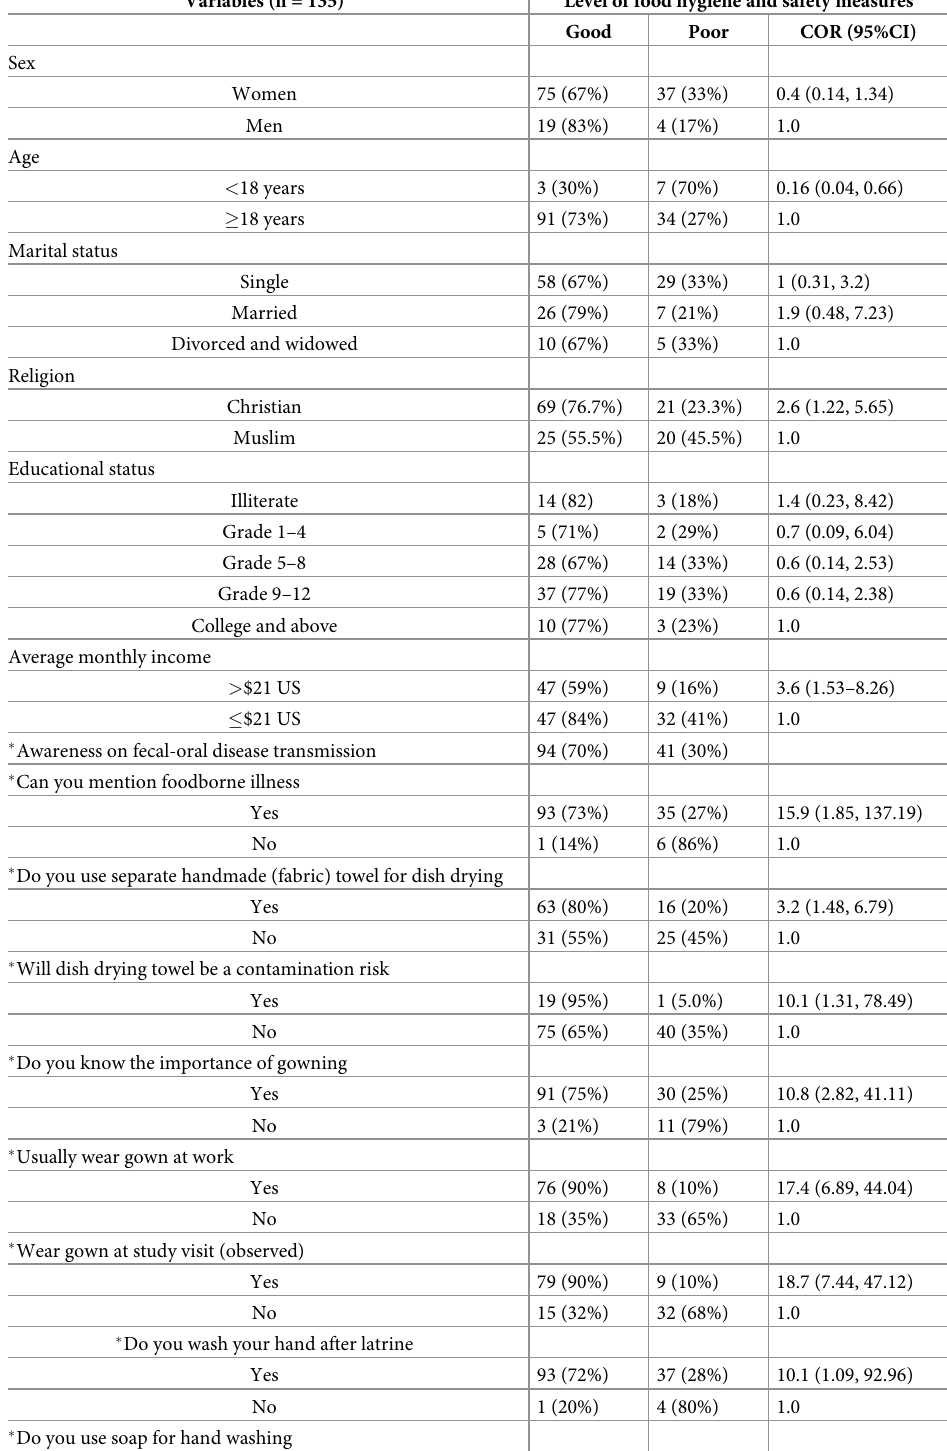
Table 4. Bivariate analysis of the level of food hygiene and safety measures among all food handlers from Decem- ber 2013 to June 2014, Dessie town,